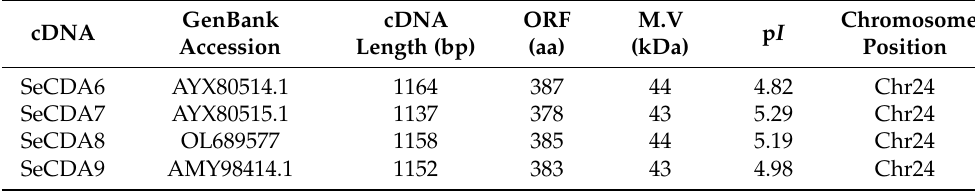
Table 1. Summary of Group V SeCDAs in S. exigua .